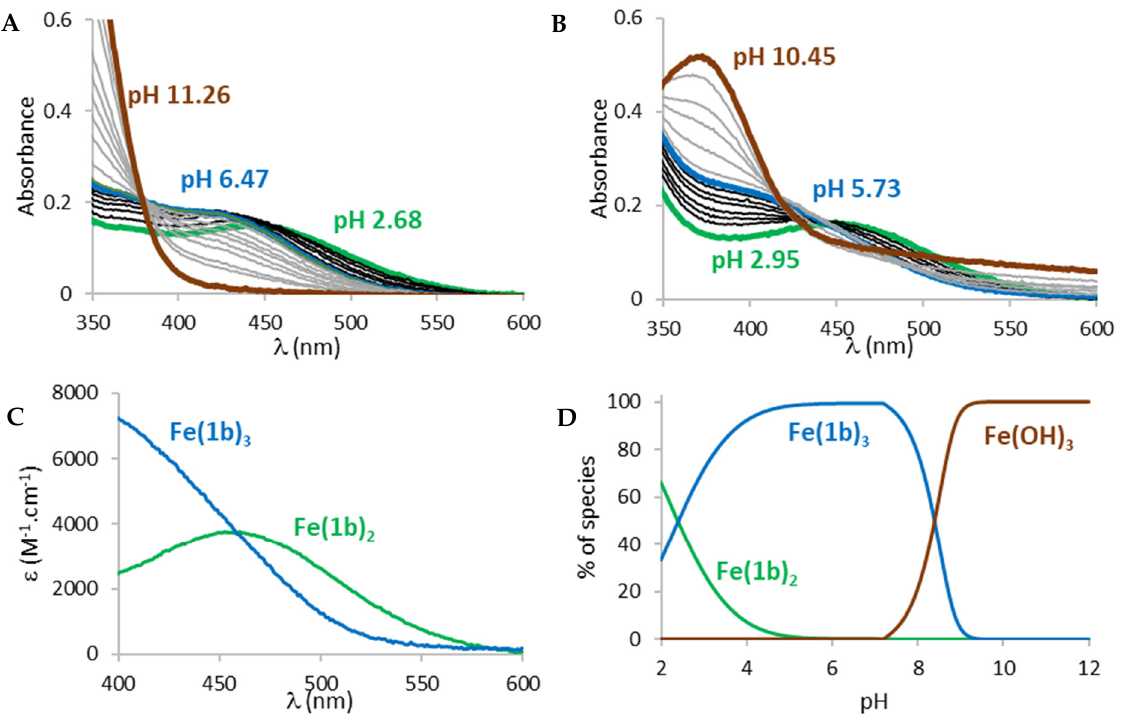
Figure 4. Spectrophotometric titration vs. pH of Fe(III) complexes of ( A ) ligand 1a (2.68 ≤ pH ≤ 11.26, [ 1a ] = 1.01 × 10 −4 M, [Fe 3+ ] = 3.20 × 10 −5 M) and ( B ) ligand 1b (2.95 ≤ pH ≤ 10.45, [ 1b ] = 1.01 × 10 −4 M, [Fe 3+ ] = 4.35 × 10 −5 M). ( C ) Electronic spectra of Fe 3+ complexes of 1b and ( D ) distribution curves of Fe(III) complexes of 1b ([ 1b ] = 1.01 × 10 −4 M, [Fe 3+ ] = 3.20 × 10 −5 M). Solvent: MeOH/H 2 O (80/20 w / w ), I = 0.1 M (NaClO 4 ), T = 25.0 °C.